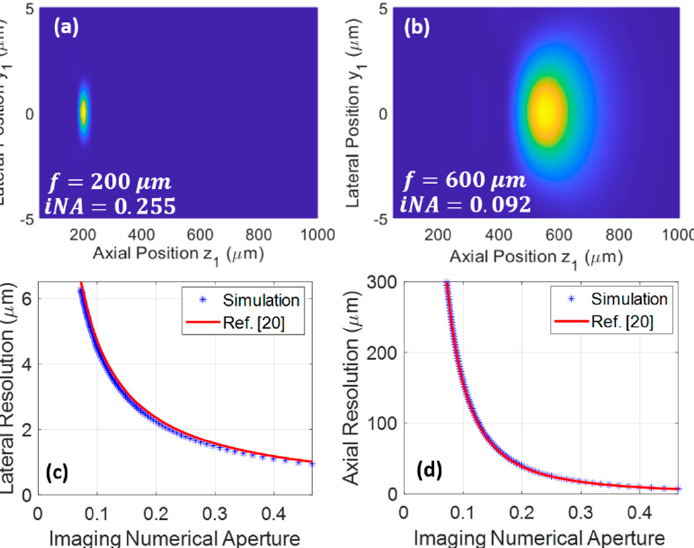
Figure 6. Simulated resolution. Distribution of I f when f = 200 µ m ( a ) and 600 µ m ( b ). Calculated lateral ( c ) and axial ( d ) resolution vs. imaging numerical aperture ( iNA ). Here, resolution is defined by the 1/e full width of the signal intensity (i.e., I f ) fitted to a Gaussian function. Simulation parameters are the same as those in Figure 2, except Z 0 = 1058 mm (equal to 90 times average Z p minus 1 mm).